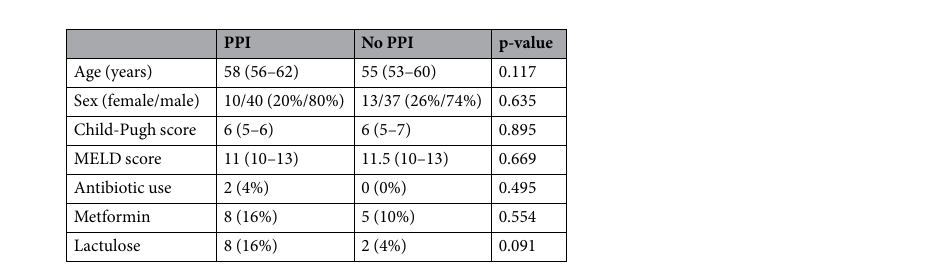
Table 1. Patients characteristics for propensity score matched pairs (n = 50). Data is given as median and 95% confidence interval. PPI: proton pump